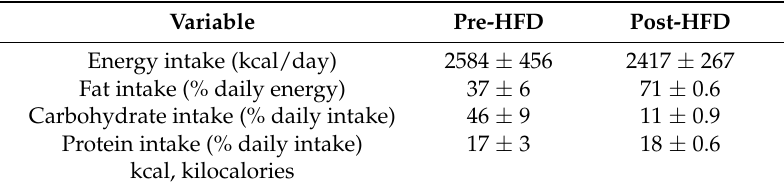
Table 1. Pre- and post-HFD (high-fat diet) macronutrient and energy